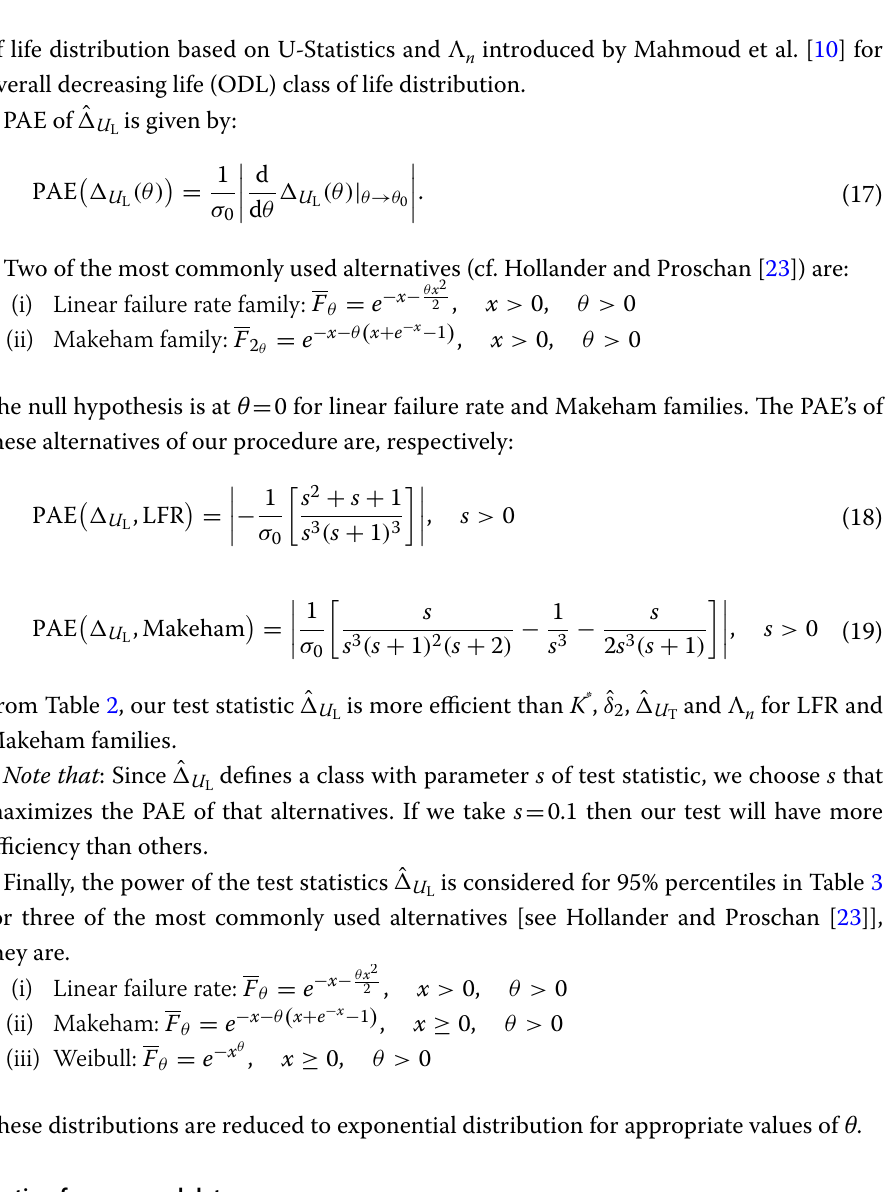
Table 2 PAE of (cid:31) U Distribution K